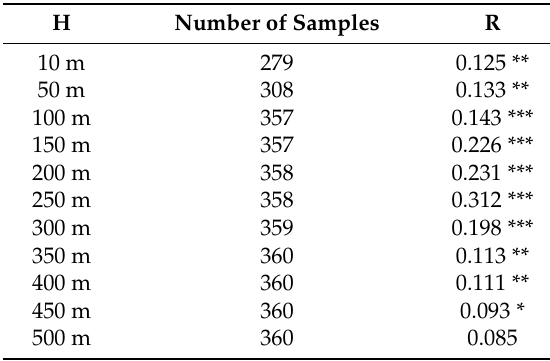
Table 3. Correlation (R) between BLSI and ground air quality at each